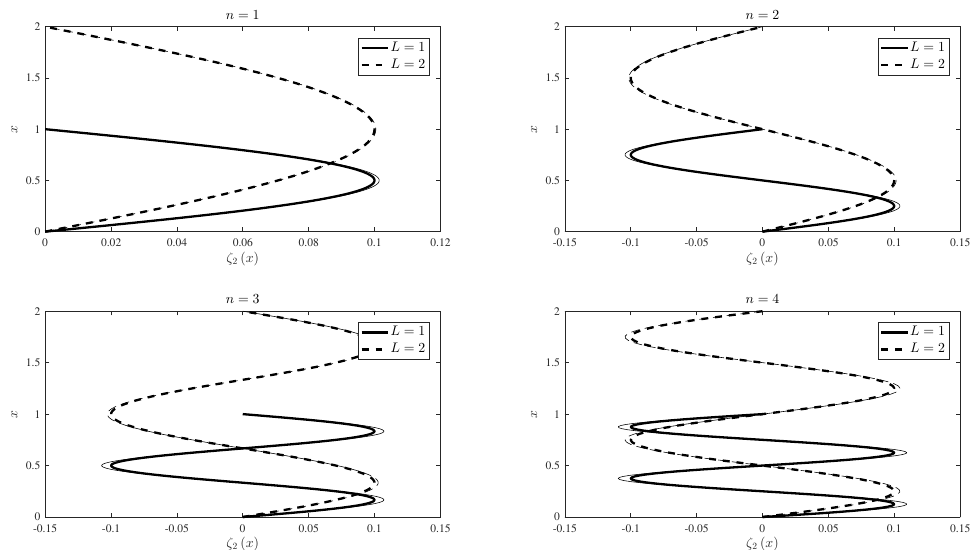
Figure 16. Comparison of the mode shapes of the buckled elastic pinned beam assuming a small slope (thick lines), ( ζ (cid:48) ) 2 (cid:28) 1 or assuming a lowest-order non-linear slope (thin lines), ( ζ (cid:48) ) 3 (cid:28) 1, for the four lowest buckling forces, n = 1, . . . ,4. The indeterminate constant is set as b = 0.1, and the length of the beam is L = 1 or L =